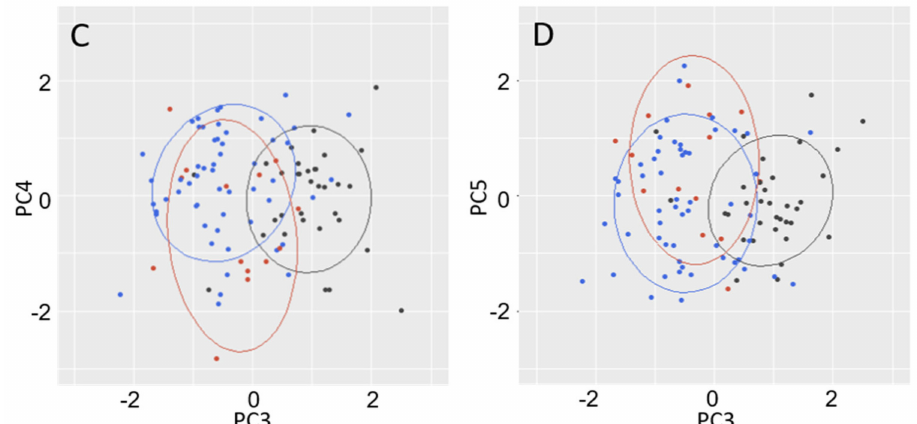
Figure 5. Elliptical plots of PCs where TS trees were statistically different ( p < 0.05) from both TN and C trees based on Tukey comparisons from ANOVA. These included ( A ) PC1 and PC3, ( B ) PC2 and PC3, ( C ) PC3 and PC4, and ( D ) PC3 and PC5. Dots represent individual trees; ellipses show boundaries encompassing 65% of all data